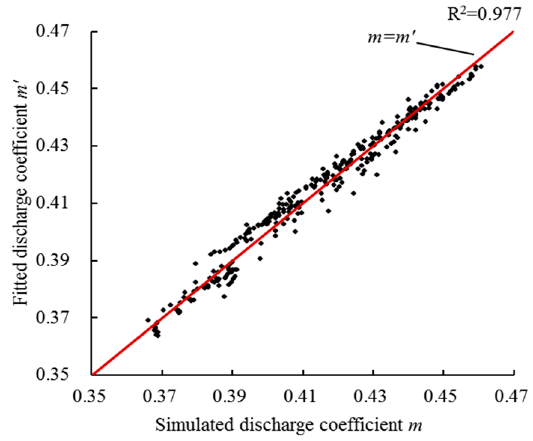
Figure 7. Comparison between m ′ and m.